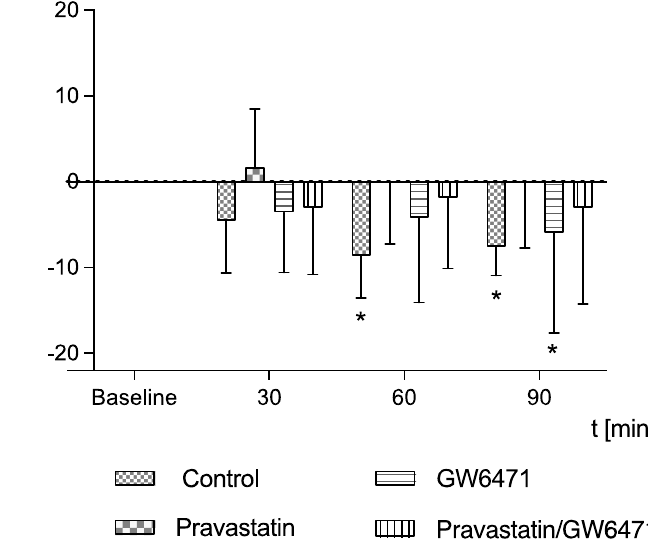
Figure 1. Postcapillary oxygenation of the colon ( µ HbO 2 ) was measured in untreated septic animals (control) and after treatment with pravastatin, PPAR- α -antagonist GW6471, pravastatin and GW6471. Data are presented as absolute percentage points with regard to baseline values and shown as mean + SD, n = 10, * p < 0.05 vs. baseline.